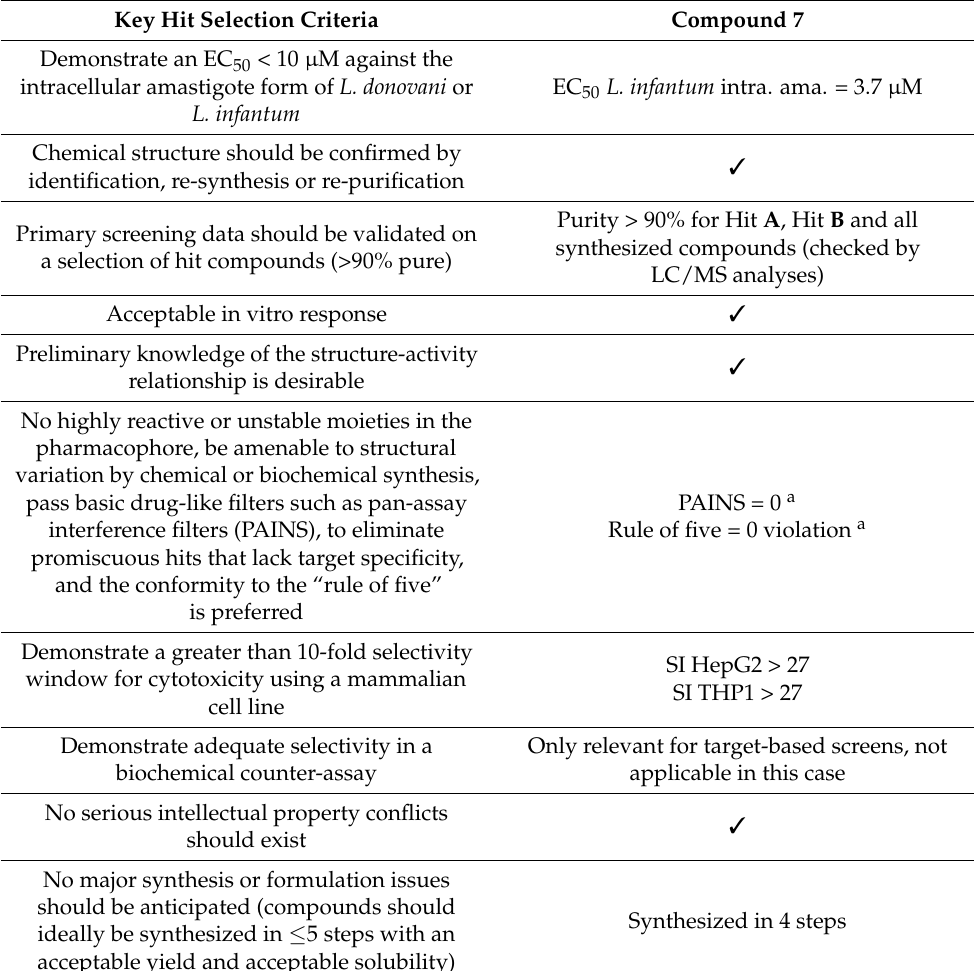
Table 5. Validation of key antileishmanial hit selection criteria by compound 7 . Key Hit Selection Criteria Compound